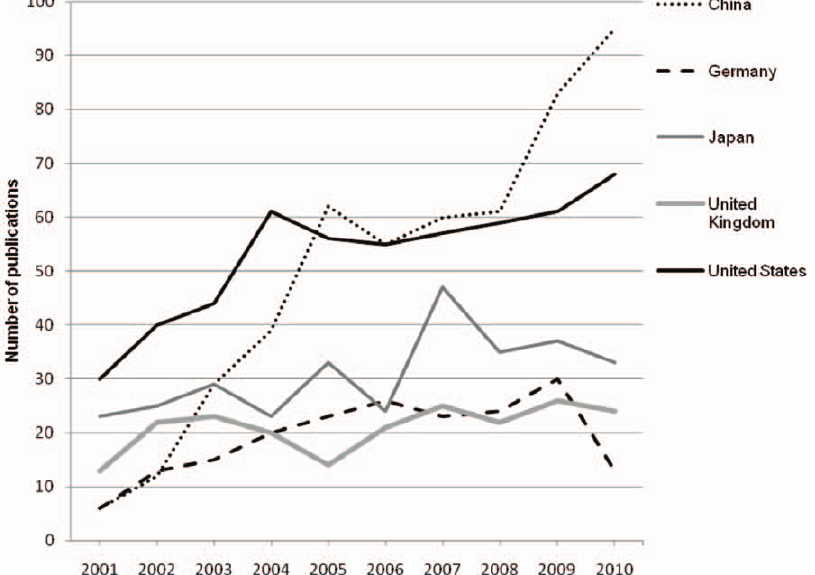
Figure 3. Five countries with the largest numbers of infectious disease-related publications in human genome epidemiology (HuGE), 2001–2010.